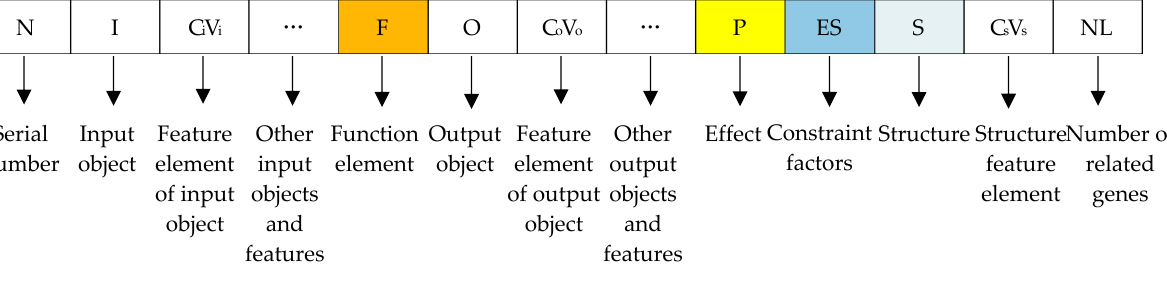
Figure 8. Product gene model.